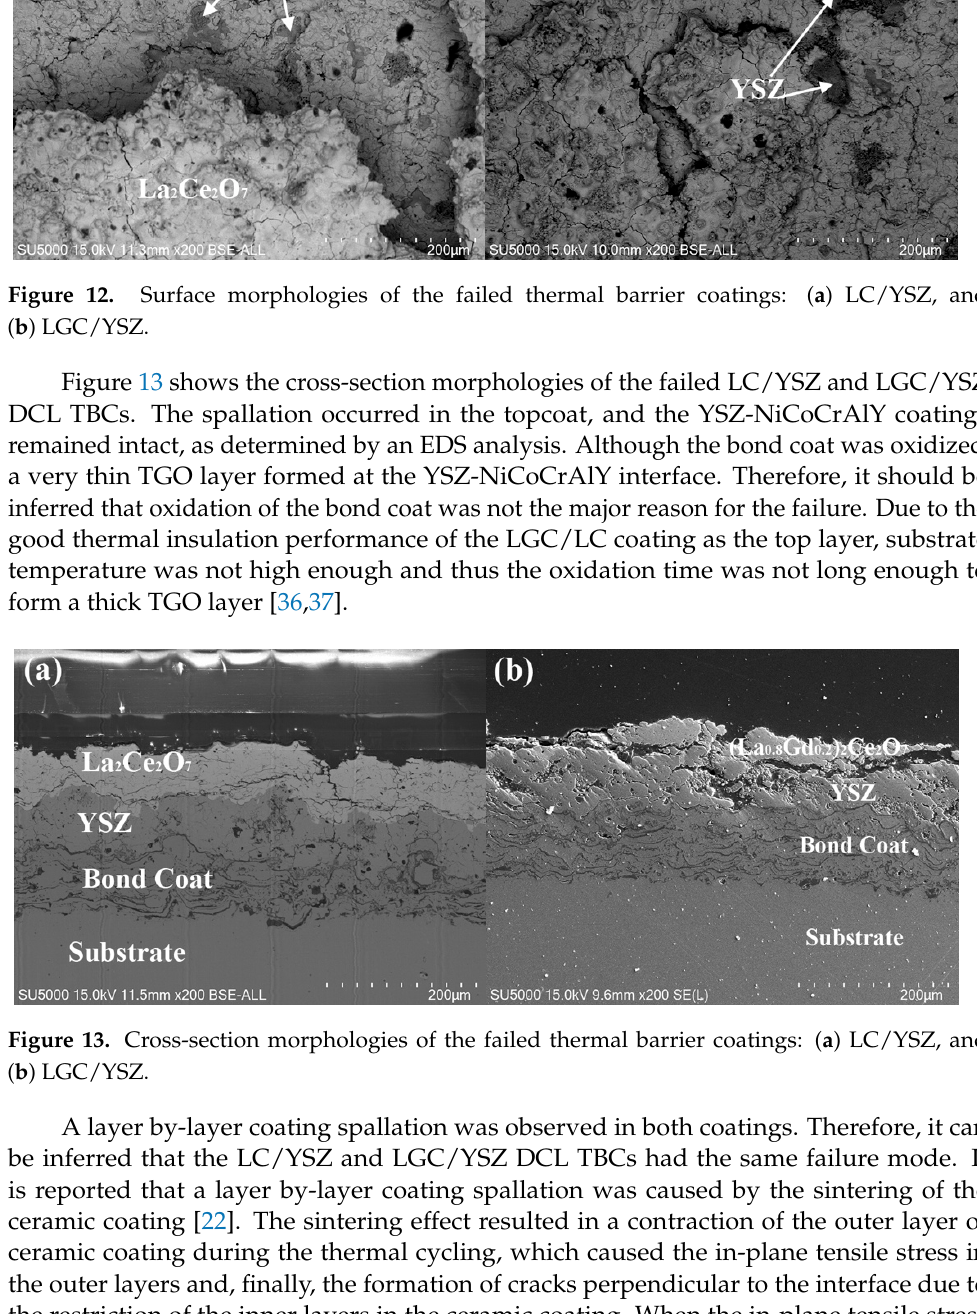
Figure 11. The macro-image of the failed coatings after thermal shock test: ( a ) LC/YSZ after 68 ther- mal cycles, and ( b ) LGC/YSZ after 109 thermal cycles.